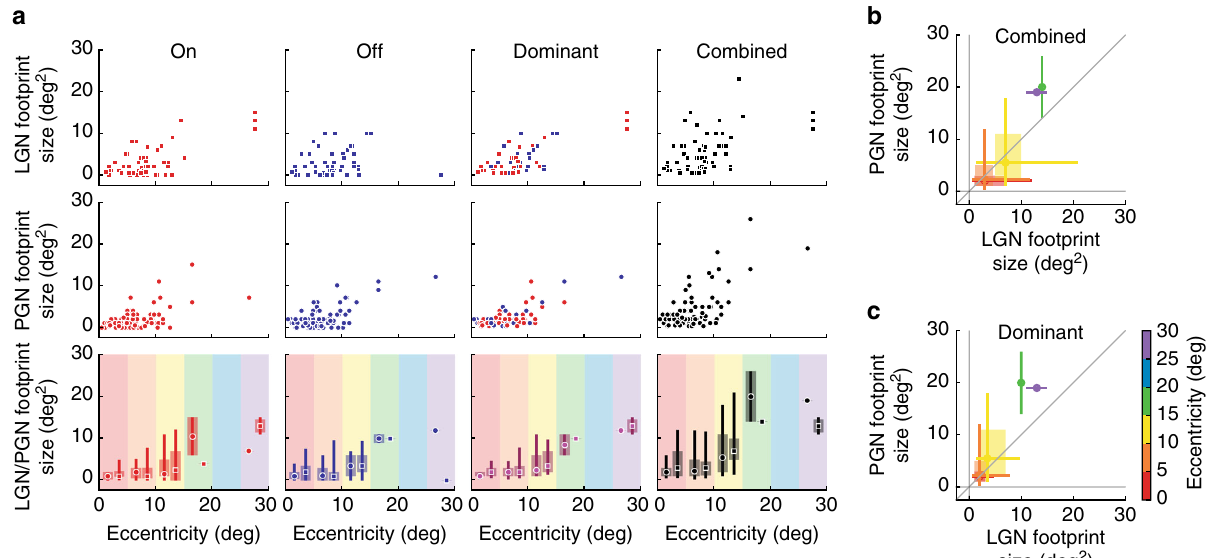
Fig. 4 Receptive fi eld size as a function of eccentricity. a Scatter plots of footprint sizes as a function of eccentricity, for LGN ( square symbols , top row ) and PGN ( circular symbols , middle row ) for either on, off, the dominant, or both stimulus polarities. Note the dominant footprint was on or off, whichever had the larger magnitude, and the combined footprint was the union of the on and off regions. Footprint sizes in the LGN vs. PGN ( bottom row ) increase with increasing eccentricity (binned at 5° intervals); the square (LGN) or circular (PGN) symbols in each bin mark the mean, the wide pale bars associated with the symbols denote the quartiles, and the lines indicate extreme values. b , c A direct comparison of combined ( b ) and dominant ( c ) footprint sizes for PGN (ordinate) vs. LGN (abscissa) across eccentricities; the line of unity slope is in gray ; conventions as in ( a ). The footprints were calculated with a threshold of q = 0.01; see Supplementary Fig. 2 for footprints calculated with more relaxed or more stringent